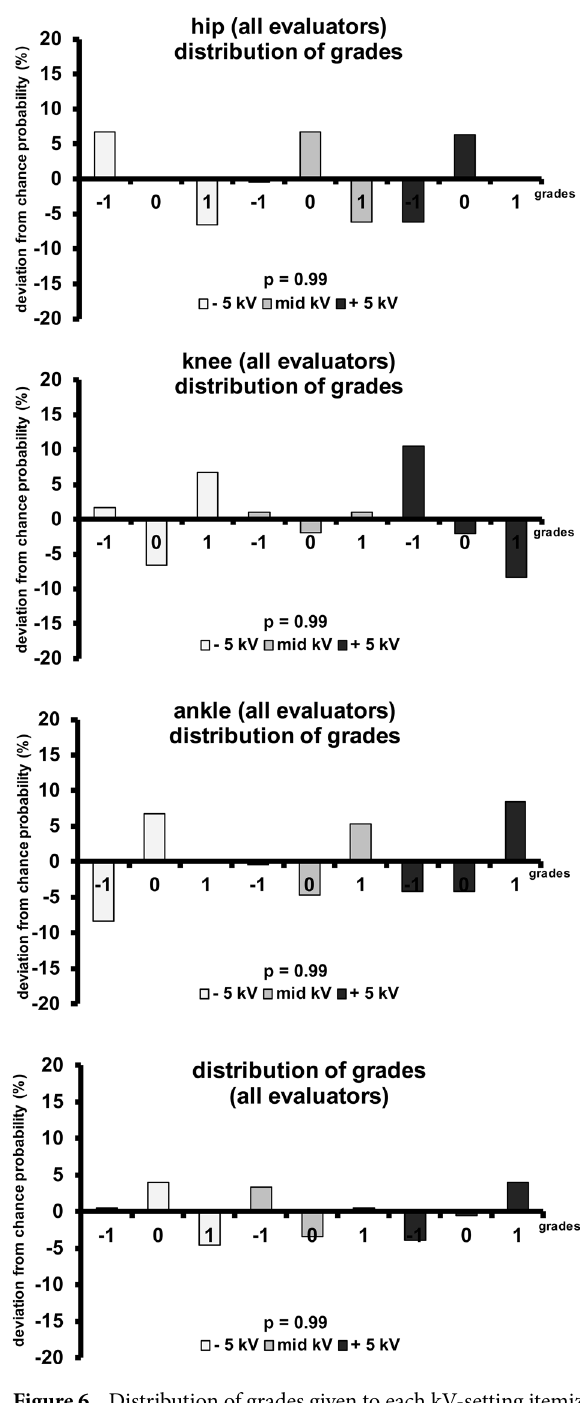
Figure 6. Distribution of grades given to each kV-setting itemized by body region. Three blinded evaluators graded the image quality (IQ) of a triplet with a 3-point scale (−1 = worst IQ of the triplet, 0 = middle IQ of the triplet, + 1 = best IQ of the triplet). The deviation from chance probability (33.3%) was insignificant in all body regions and all evaluators (p = 0.99). Agreement of the actual grades distribution with chance probability is highly probable (κ = −0.03), suggesting that evaluators were not able to differentiate kV-settings by IQ. The agreement between the evaluators was poor (κ = 0.01), indicating that the distribution of the grades given by the evaluators was